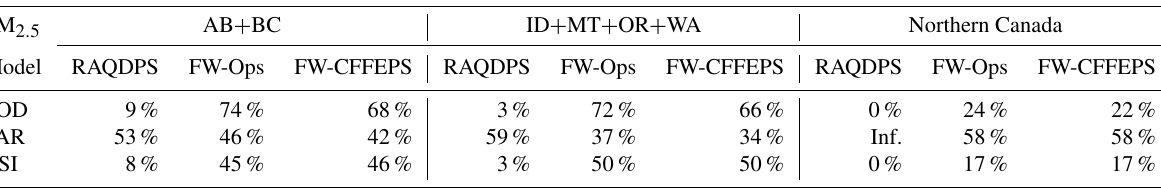
Table 9. PM 2 . 5 categorical scores based on a threshold of 30µgm − 3 for 1 August to 18 September 2017 for stations in the AB + BC, ID + MT + OR + WA, and northern Canada regions.